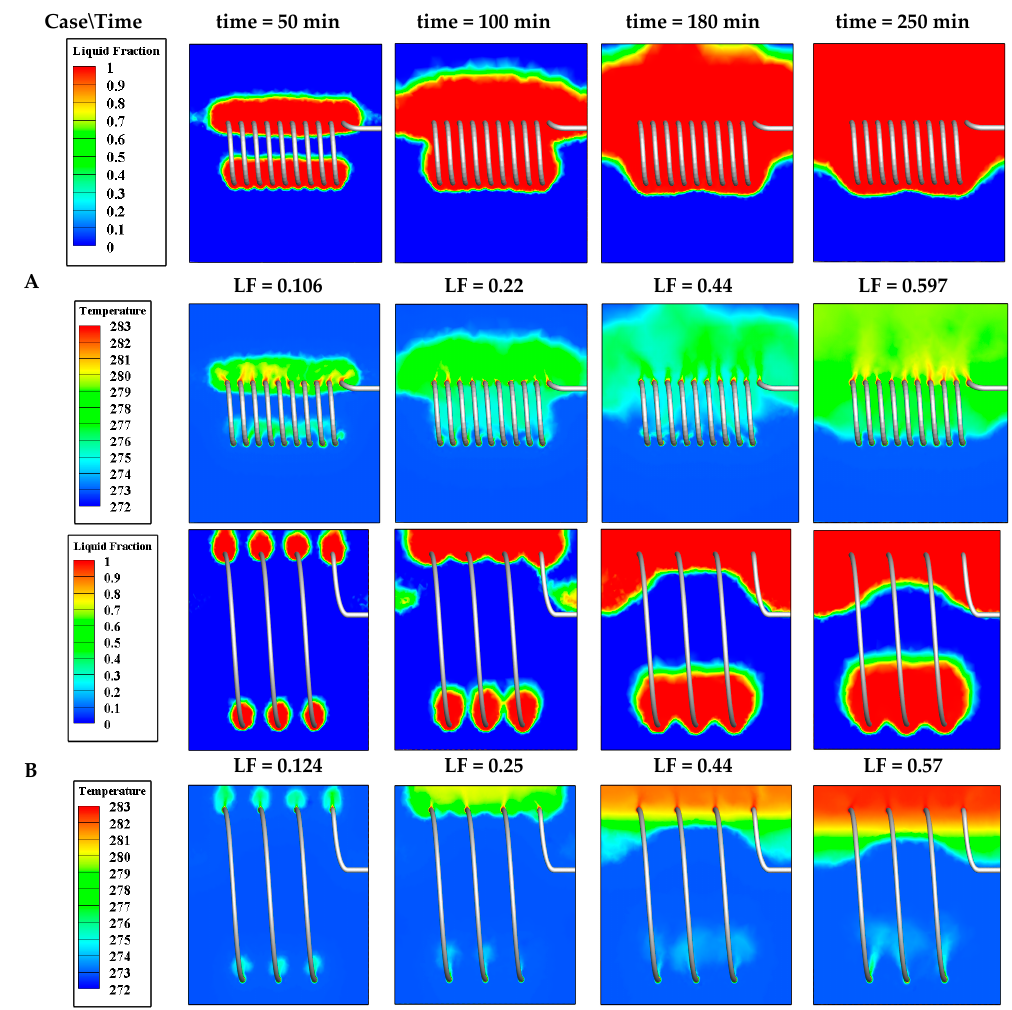
Figure 13. Contours of the liquid fraction and temperature for cases A and B at four different times in the plane x = 0.